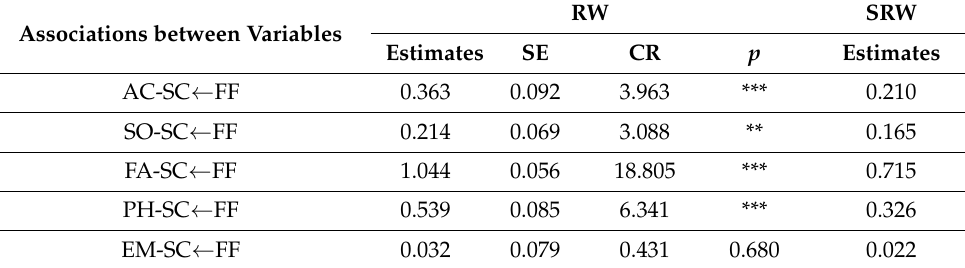
Figure 2. Model developed for students who practice more than 3 h of PA per week. Note: Family functionality (FF); Academic self-concept (AC-SC); Social self-concept (SO-SC); Family self-concept (FA-SC); Physical self-concept (PH-SC); Emotional self-concept (EM-SC). Table 3. Results of the proposed structural model for participants practicing more than 3 h of PA per week. RW Associations between Variables